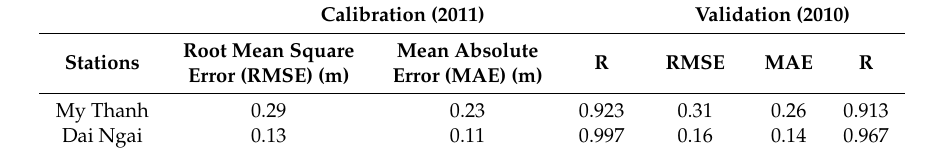
Table 5. Statistical performance of calibration and validation at My Thanh and Dai Ngai stations. Calibration (2011) Validation (2010)